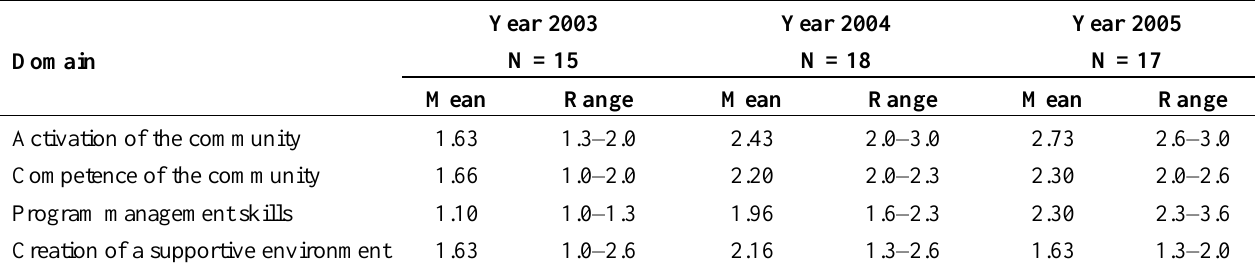
Table 8. Community empowerment domains assessed by the Elderly Quality of Life program